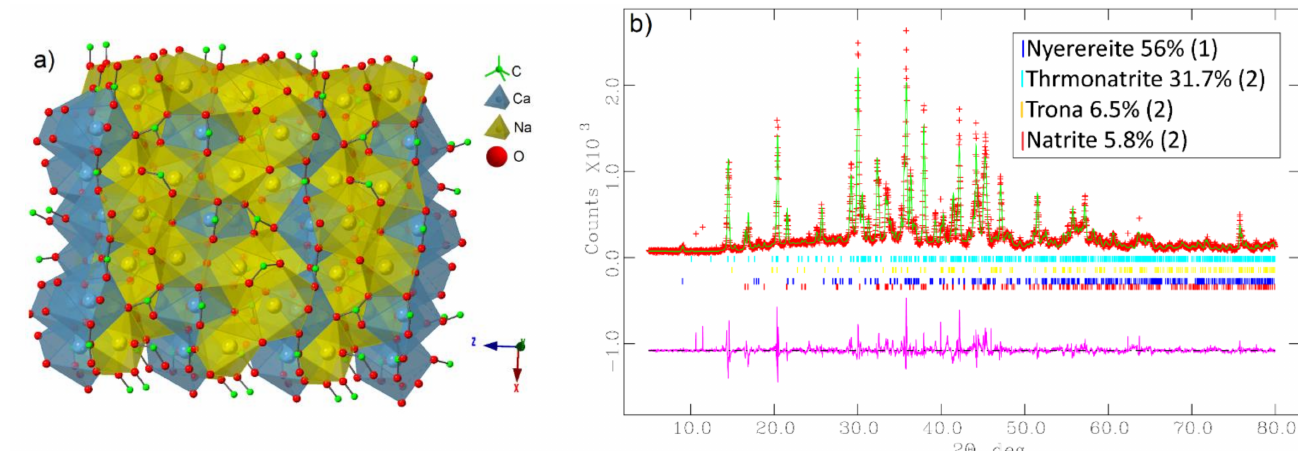
Figure 3. ( a ) Crystal structure of nyerereite projected along the y-axis [72]. The sticks represent the C . . . O bonds. ( b ) X-ray diffraction pattern of the sample collected at room temperature and refined by the Rietveld method [60] with Rp:0.09.